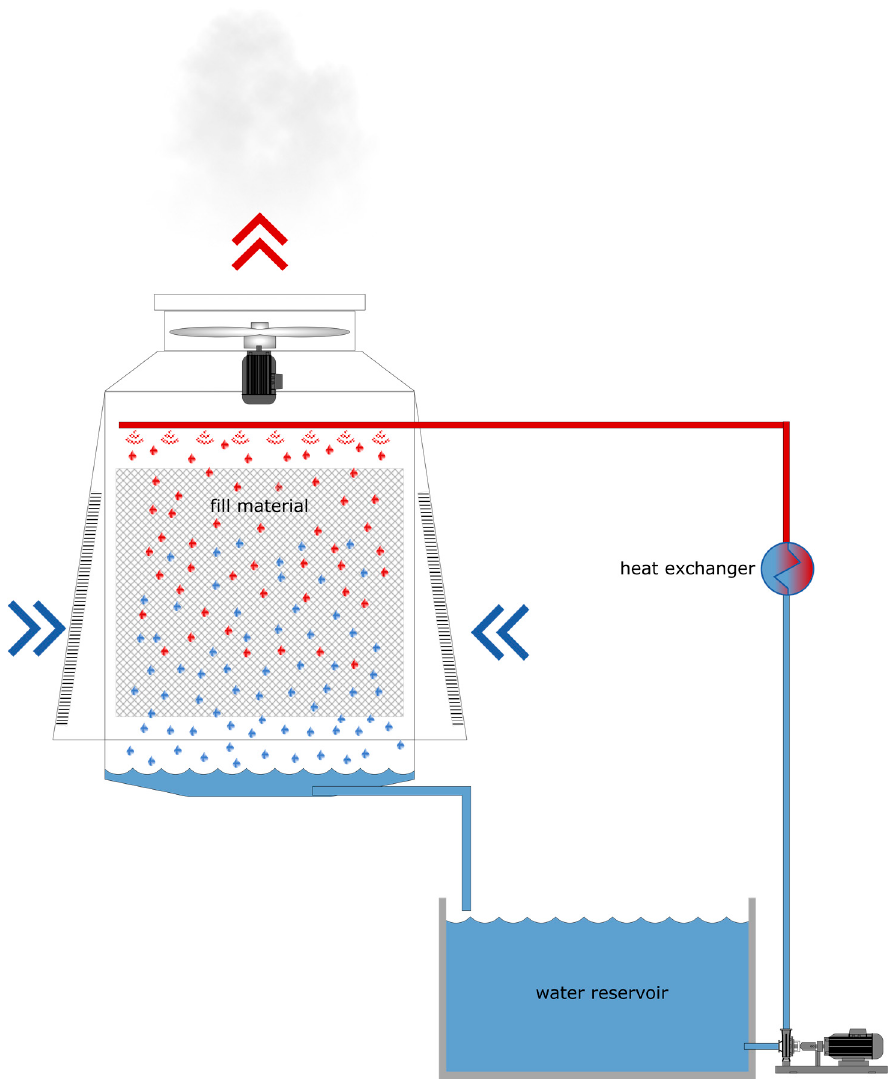
Figure 1. Sketch of an evaporative cooling tower with a water reservoir, fill material and heat exchanger. Microbial communities can thrive within the humid environment, both in planktonic form as well as in biofilms on all surfaces.